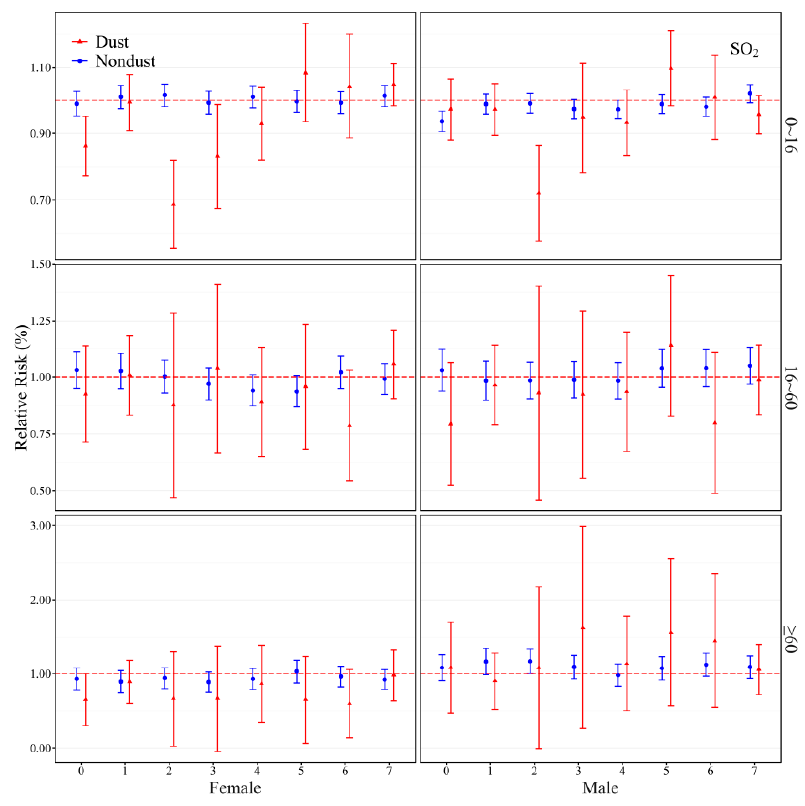
Figure 3. RRs (95% CIs) of ER visits with an increase of 10 µ g/m 3 in air pollutants in multi-pollutant models in spring, 2007–2011. All models were controlled for time trend, DOW, holiday and weather conditions.